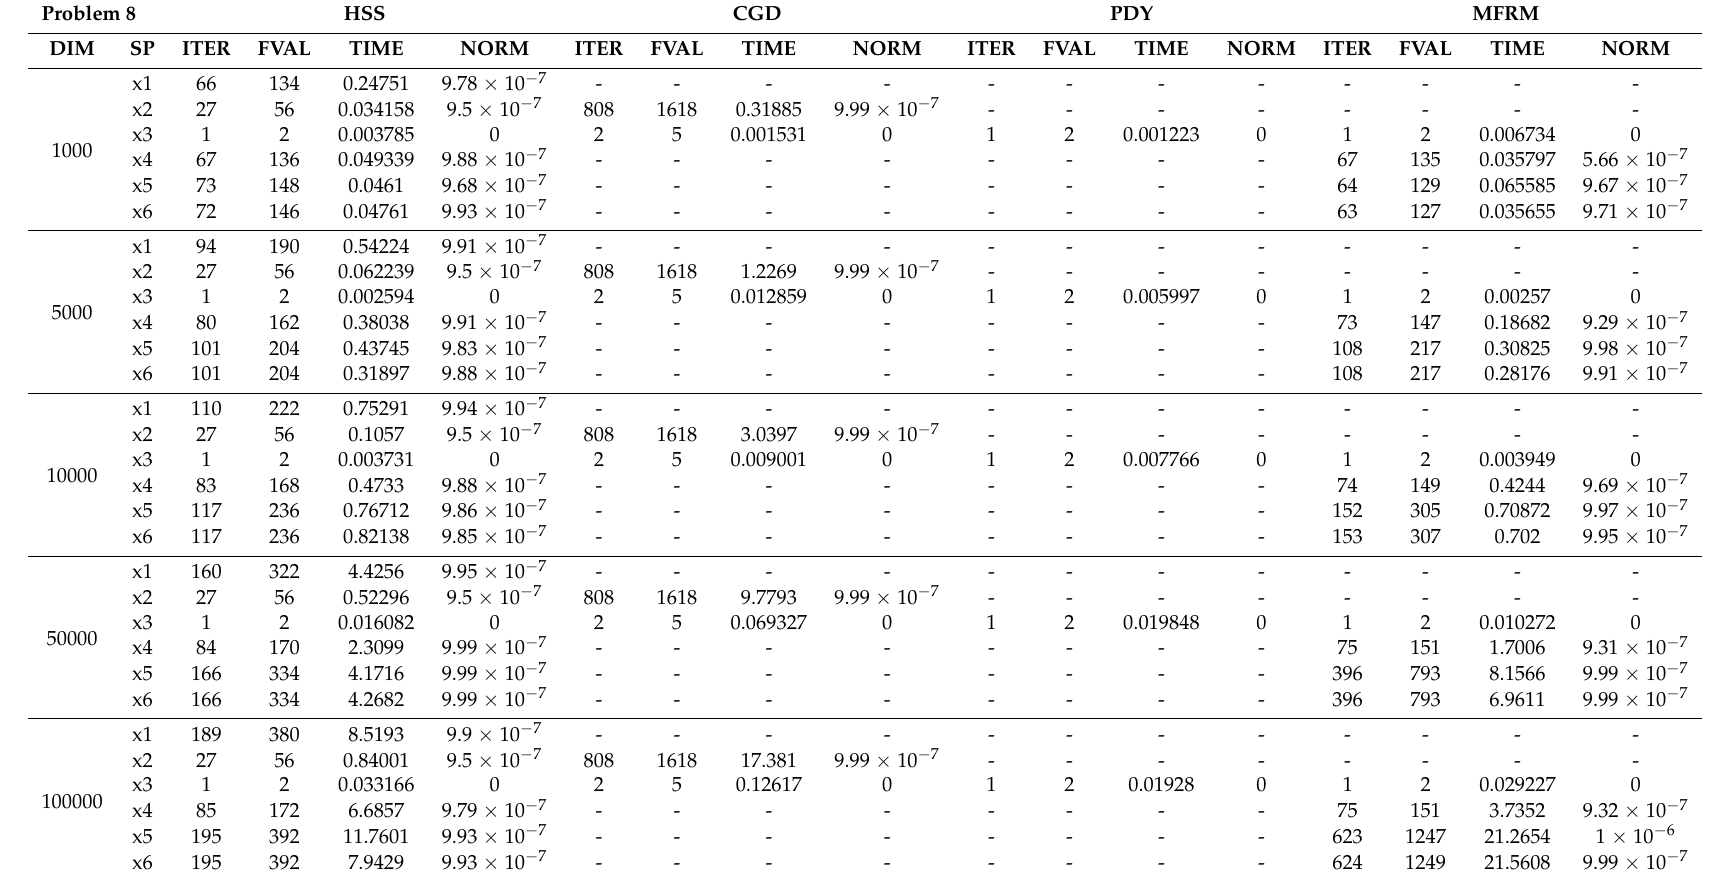
Table 8. Test results obtained by the four solvers for Problem